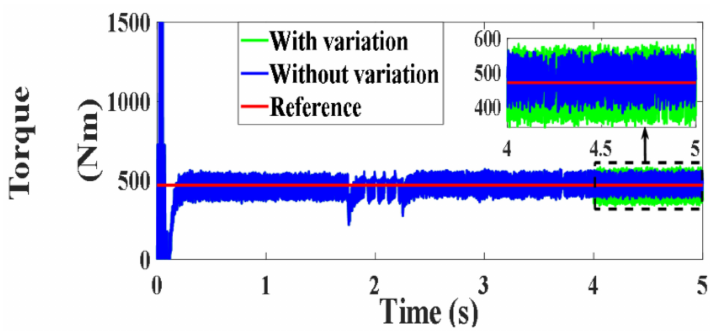
Figure 117. Developed torque under PVC (Nm).